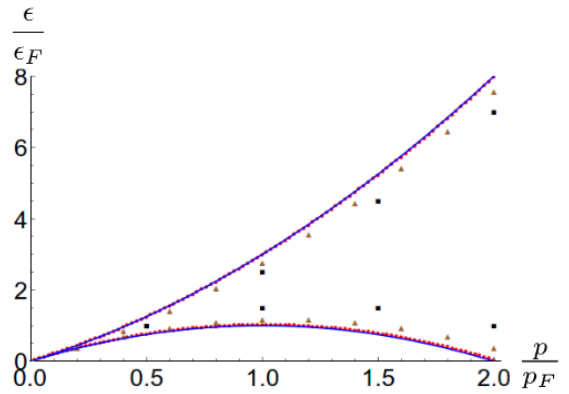
Figure 8: Excitation energy of the Tonks-Girardeau gas ε in units of the Fermi energy in the = (cid:126) 2 π 2 N 2 thermodynamic limit ε , as a function of the excitation momentum p , in units of F 2 mL 2 = (cid:126) π N the the Fermi momentum in the thermodynamic limit p , for N = 4 (black squares), F L N = 10 (brown triangles), N = 100 (red dots). The last one is quasi-indistinguishable from the excitation spectra in the thermodynamic limit (solid,